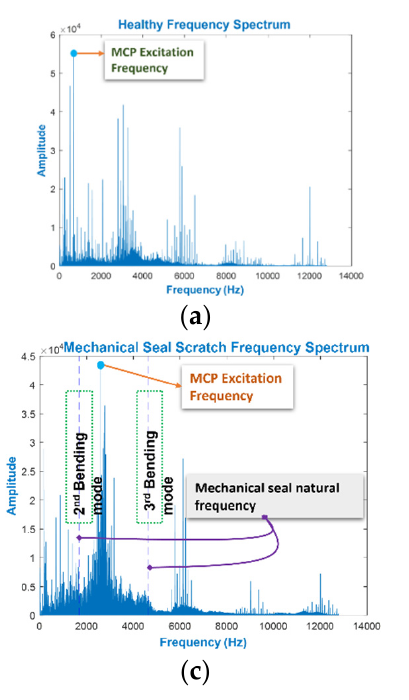
Figure 7. MCP spectrum of ( a ) NC, ( b ) MSH, and ( c ) MSS.